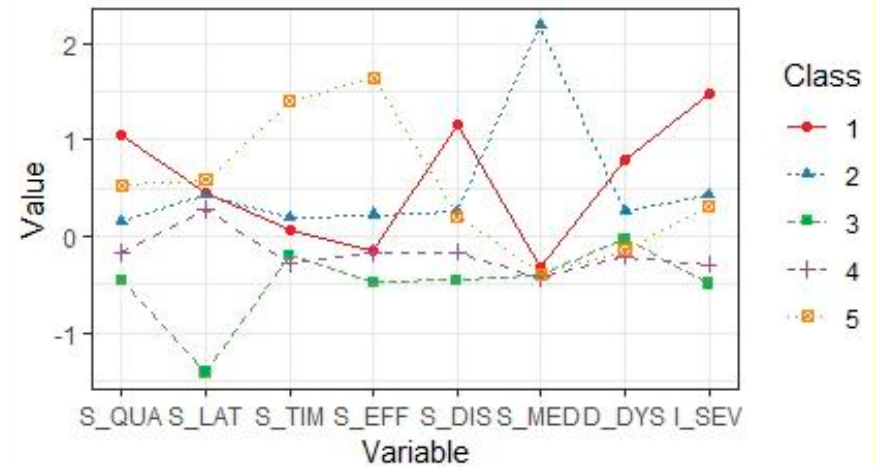
Figure 1. Graphical representation of the five-classes latent profile solution. Indicator variables (PSQI components and ISI total scores) labels are reported on the x -axis and z -scores on the y -axis. Class 1, severe insomnia (SI); Class 2, moderate insomnia with medication use (MI-MU); Class 3, subthreshold insomnia (SubI); Class 4, subthreshold insomnia with sleep latency complaints (SubI-SL); Class 5, moderate insomnia with sleep duration complaints (MI-SD).